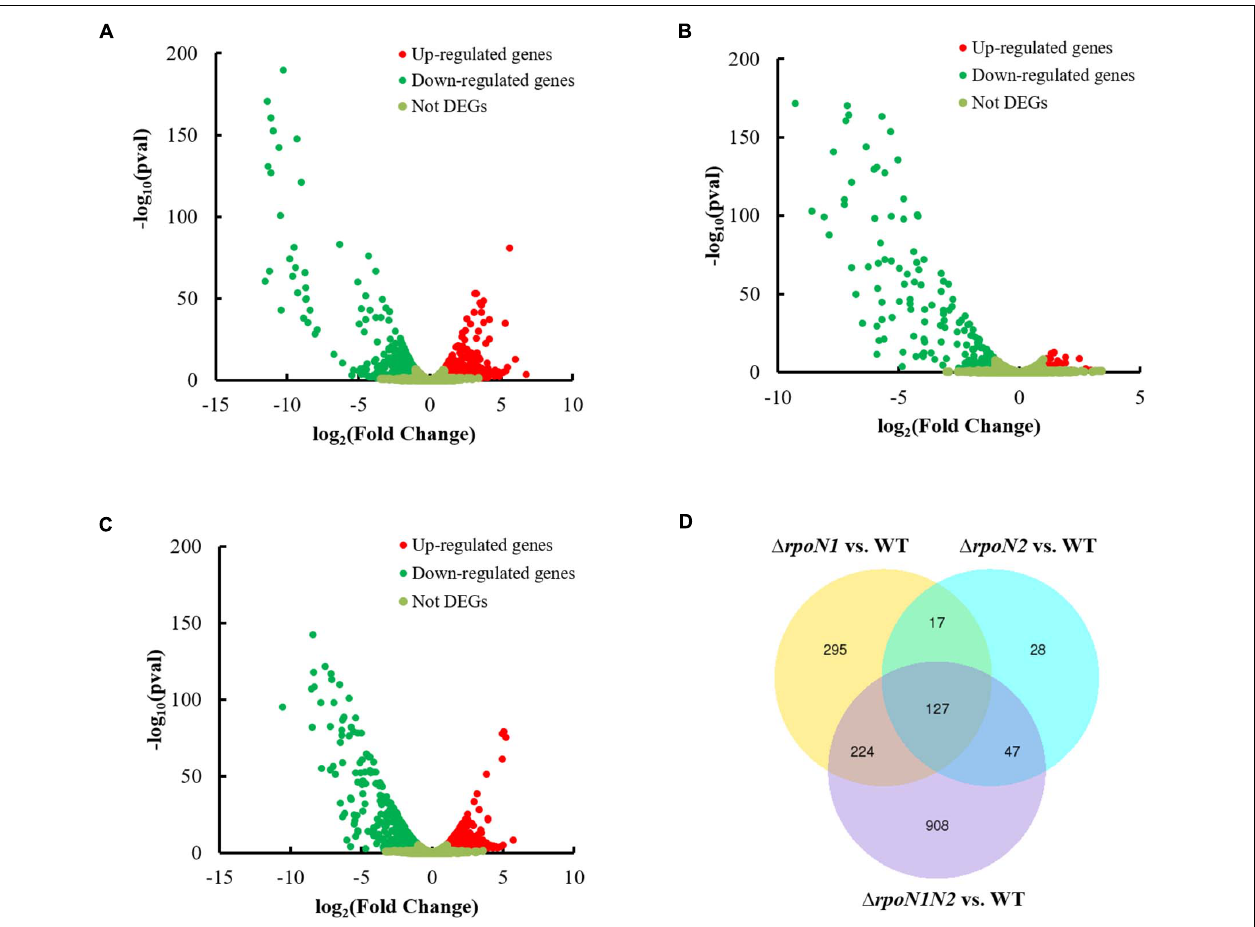
FIGURE 3 | Differentially-expressed genes (DEGs) in (cid:49) rpoN1 , (cid:49) rpoN2, and (cid:49) rpoN1N2 . DEGs in (A) (cid:49) rpoN1 , (B) (cid:49) rpoN2 , and (C) (cid:49) rpoN1N2 . Red and green dots represent up- and down-regulated genes, respectively. (D) RpoN1 and RpoN2 regulated unique and overlapping DEGs. Data represent the number of DEGs. DEGs at each mutant were selected according to the standards below: the absolute value of log 2 (Fold Change) > 1 and adjusted P -value < 0.05.